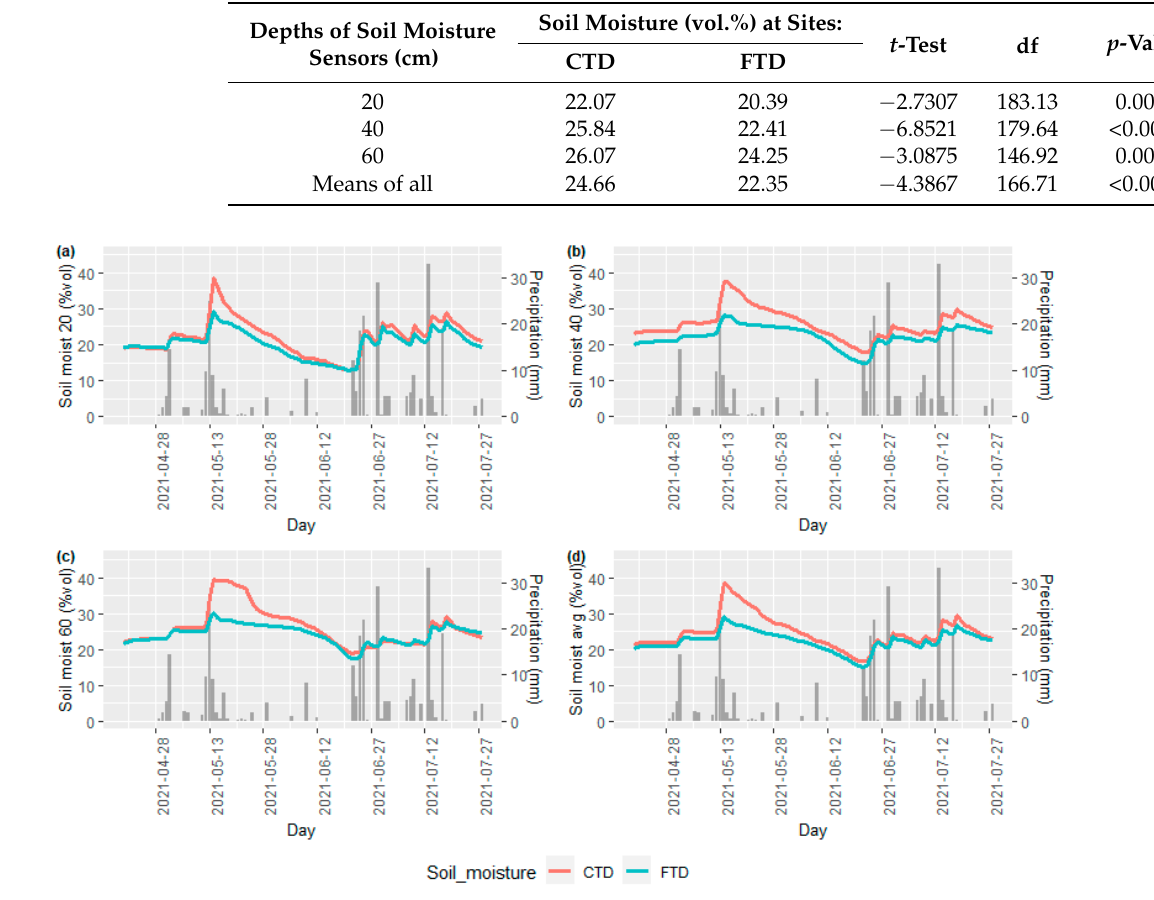
Figure 11. Daily precipitation and soil moisture at depths of ( a ) 20, ( b ) 40 and ( c ) 60 cm and ( d ) averaged over all depths at CTD and FTD sites. Table 5. Mean soil hydrolimits (field capacity FC, point of decreased availability PDA, wilting point WP, and available water capacity AWC), degree of saturation of AWC and the number of days when soil moisture was equal to or greater than PDA and FC from each and all depths at CTD and FTD